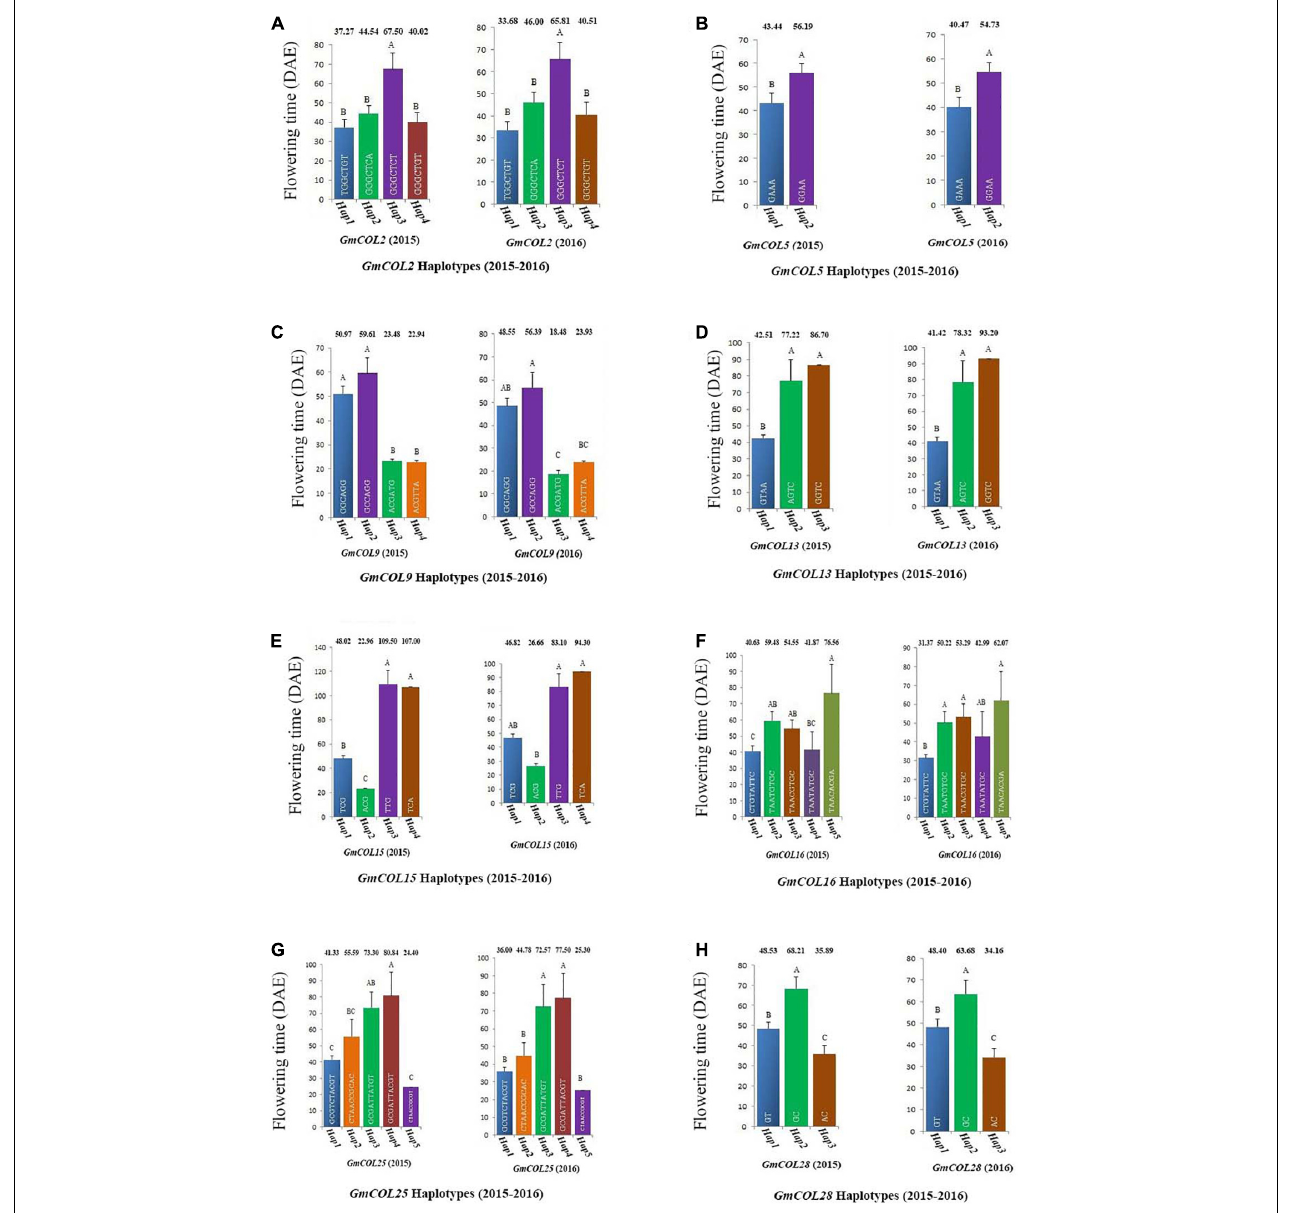
FIGURE 4 | Haplotypes of GmCOL genes in relation to flowering time (2015–2016). The relationship between flowering time and haplotype of GmCOL2 (A) , GmCOL5 (B) , GmCOL9 (C) , GmCOL13 (D) , GmCOL15 (E) , GmCOL16 (F) , GmCOL25 (G) , and GmCOL28 (H)